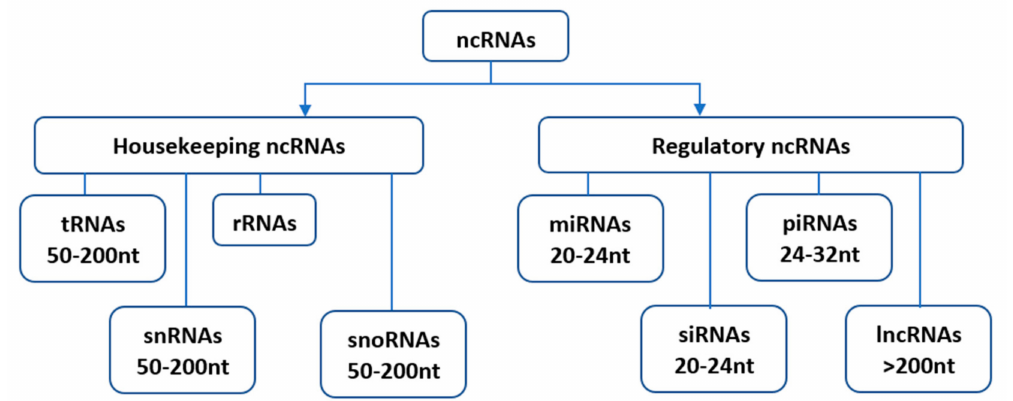
Figure 1. Classification of non-coding RNAs (ncRNAs). Housekeeping ncRNAs include; tRNAs- transfer RNAs, snRNAs-small nuclear RNAs, rRNAs-ribosomal RNAs, snoRNAs-small nucleolar RNAs. The regulatory ncRNAs consist of miRNAs-microRNAs, siRNAs-short interfering RNAs, piRNAs-piwi-interacting RNAs, and lncRNAs-long non-coding